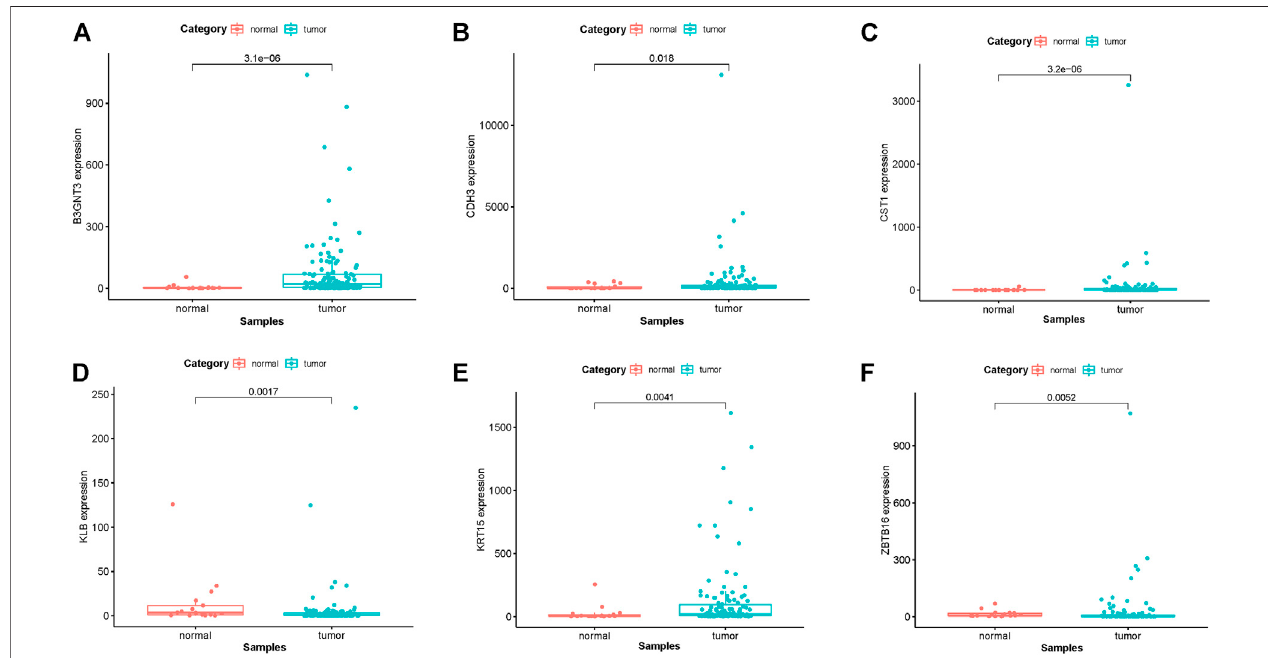
FIGURE4| TCGAdatabasewasusedtoverifytheexpressionlevelsof6hubgenesinEGFR-MTLUADandnormaltissues. (A) GeneexpressionvaluesofB3GNT3 among samples of TCGA. (B) Gene expression values CDH3 among samples of TCGA. (C) Gene expression values of CST1 among samples of TCGA. (D) Gene expression values of KLB among samples of TCGA. (E) Gene expression values of KRT15 among samples of TCGA. (F) Gene expression values of ZBTB16 among samples of TCGA.